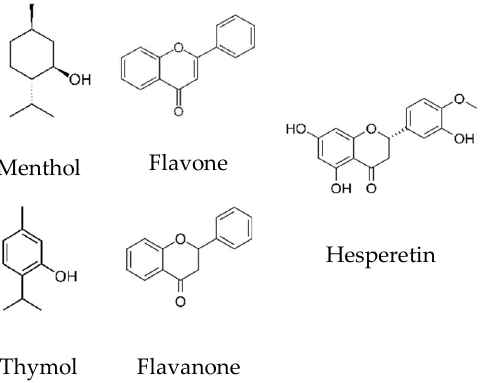
Figure 1. The chemical structure of the compounds studied in this work.